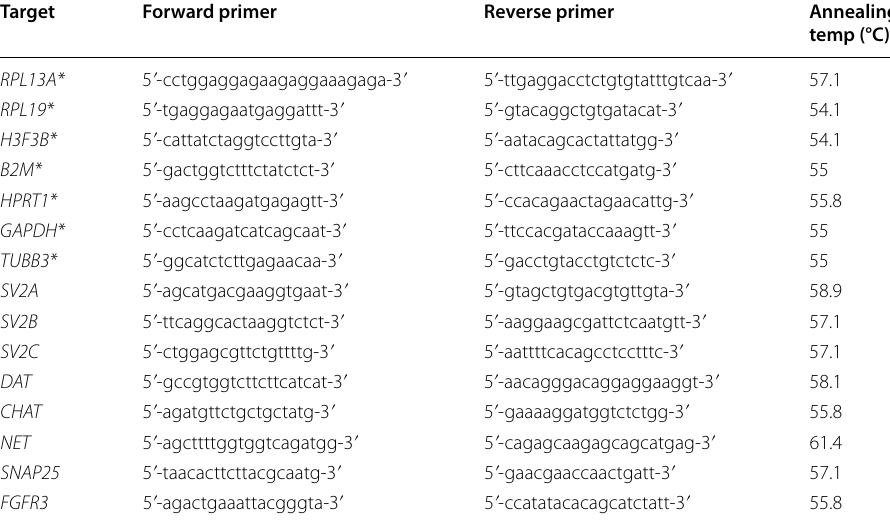
Primers used for housekeeping genes are marked with an asterisk (*)